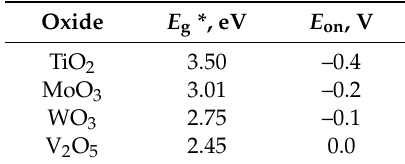
Table 3. The band gap energies ( E g ) and the photocurrent onset potentials ( E on ) for oxides used for preparation of heterostructured photocatalysts.